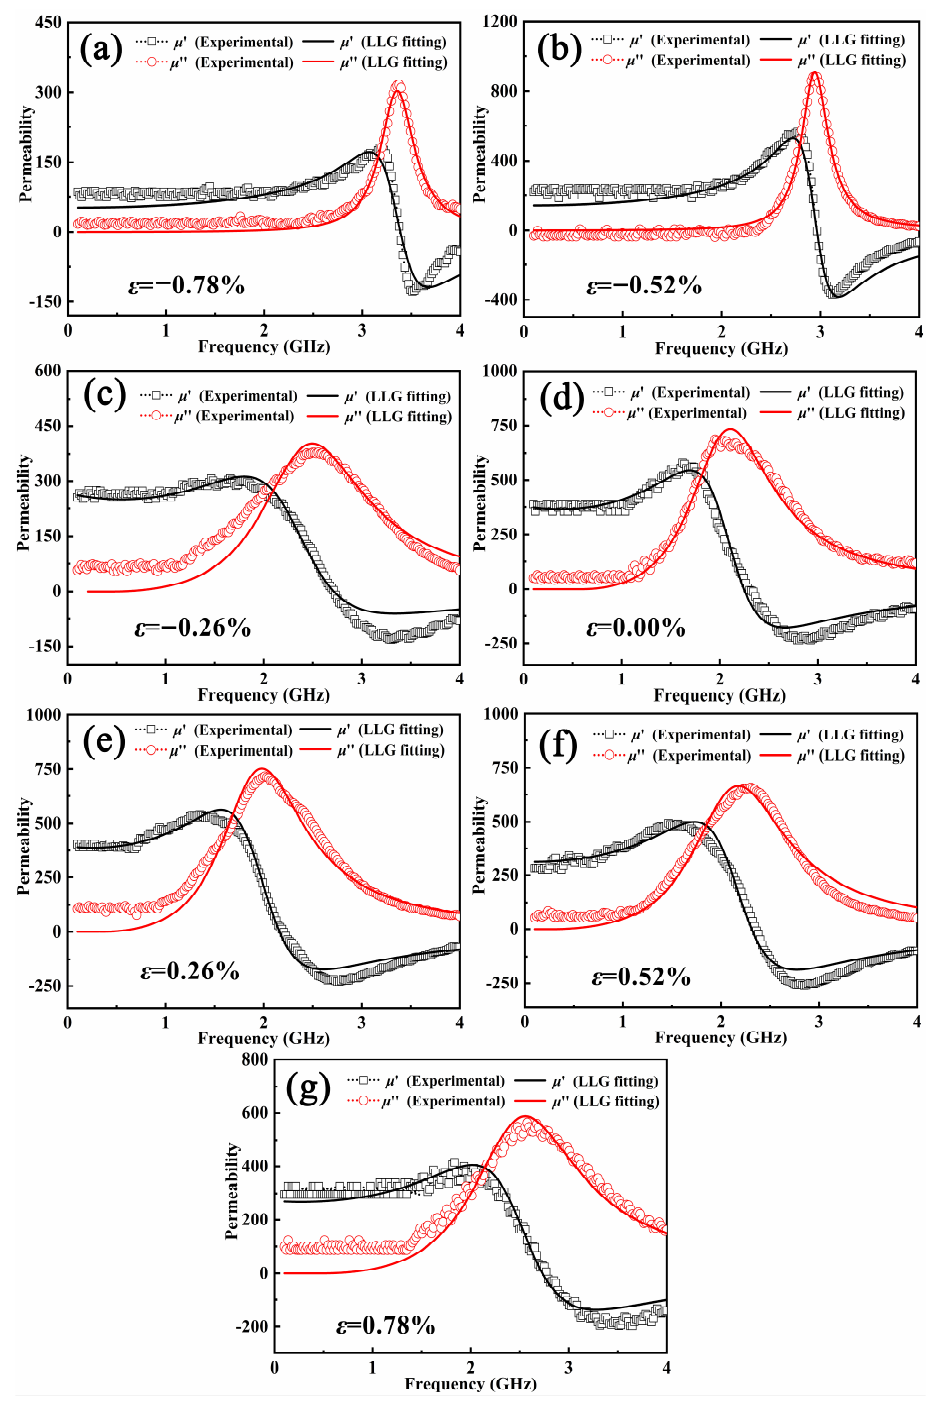
Figure 8. Permeability spectra of TFNFT films at various external strains: ( a ) ε = − 0.78%, ( b ) ε = − 0.52%, ( c ) ε = − 0.26%, ( d ) no strain, ( e ) ε = 0.26%, ( f ) ε = 0.52%, ( g ) ε = 0.78%.